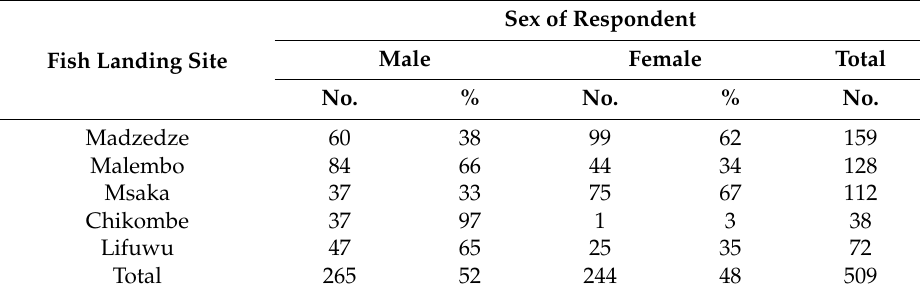
Table 1. Distribution of fisher folks at fishing landing sites by gender. Sex of Respondent Male Female Total Fish Landing Site